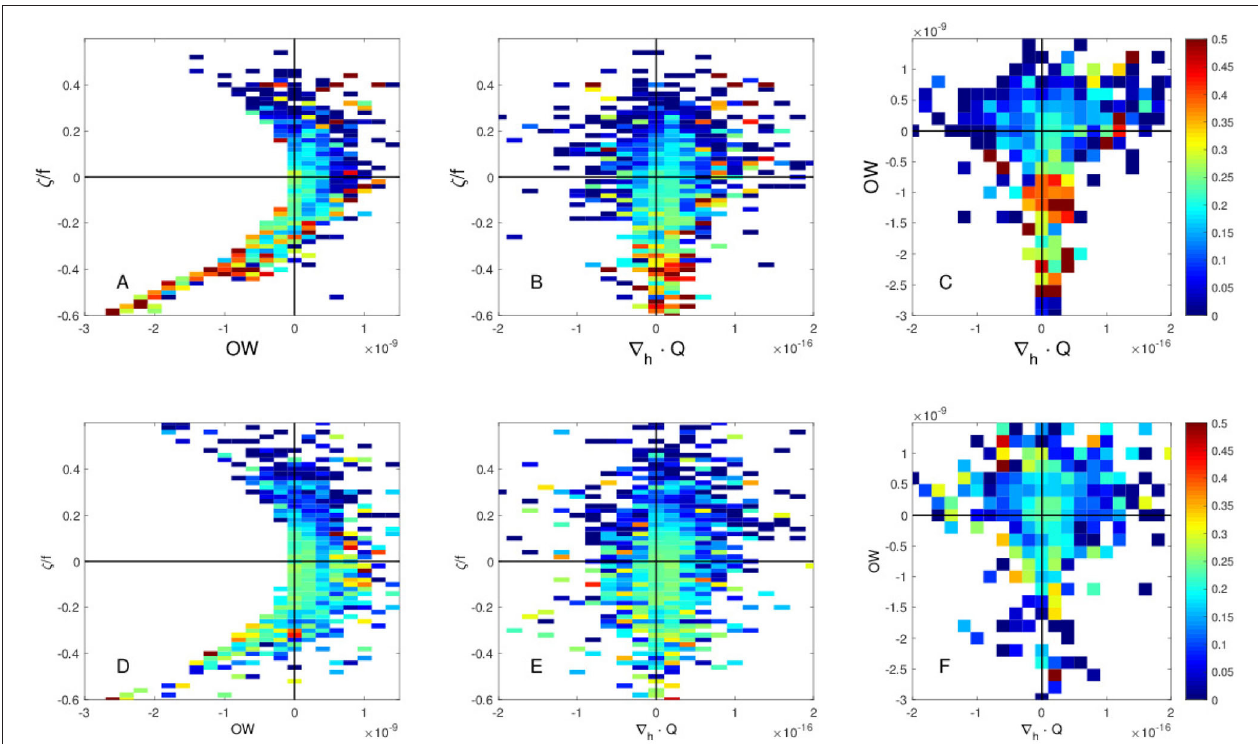
FIGURE 4 | Swordfish CPUE as a function of (A,D) Okubo-Weiss (OW) parameter (2) and vorticity (3) normalized by f Coriolis parameter, ζ/ f , (B,E) divergence of Q-vector, ∇ h · Q (4) and normalized vorticity ζ/ f , and (C,F) divergence of Q-vector and OW for (A–C) the northern region 36–45 ◦ N, and for (D–F) the southern region 25–36 ◦ N.